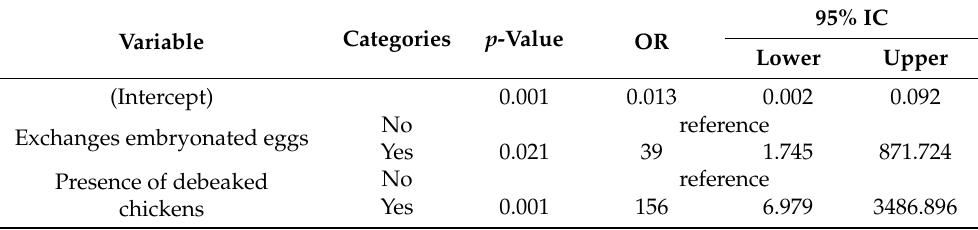
Table 7. Final model results from the multivariable logistic regression analysis. The p -value, odds ratio (OR) and 95% confidence interval (C.I.) with lower and upper limits are reported for risk factors associated with positivity to S. enterica in BPS.